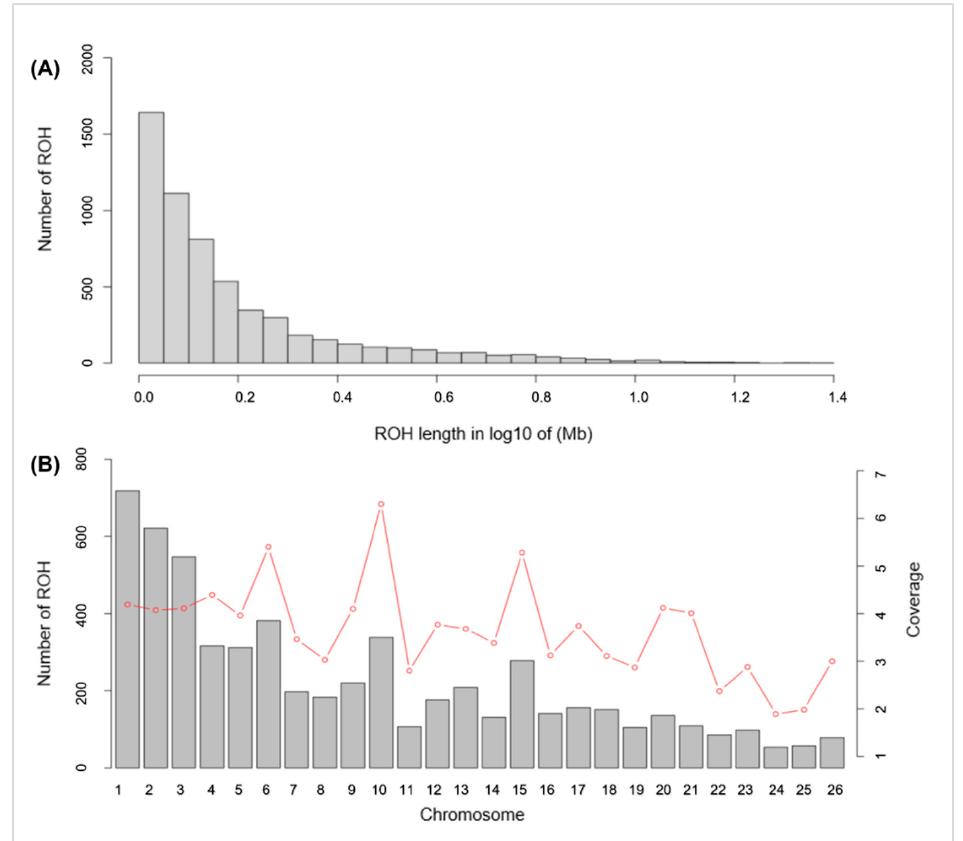
Figure 2. Distribution of the ROHs. ( A ) Length distribution of the ROHs. X -axis represents the length of the ROH (Mb) using a base-10 log scale. Y -axis represents the number of ROH for different ROH lengths. ( B ) Bars and the red dotted line represent the number of ROH and the ROH coverage, respectively, on each chromosome. Table 3. Descriptive statistics for ROHs of different lengths (Mb):1–5, 5–10, >10, and >1. ROH Length (Mb) ROH Number